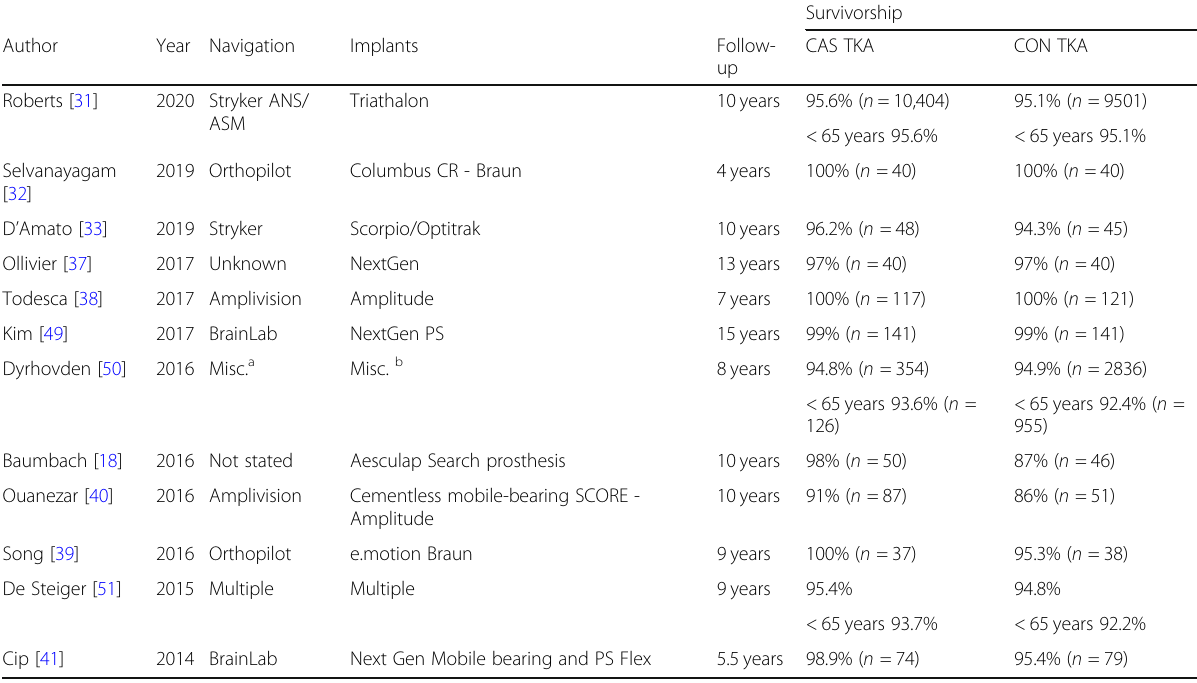
Table 2 CAS TKA versus Conventional TKA